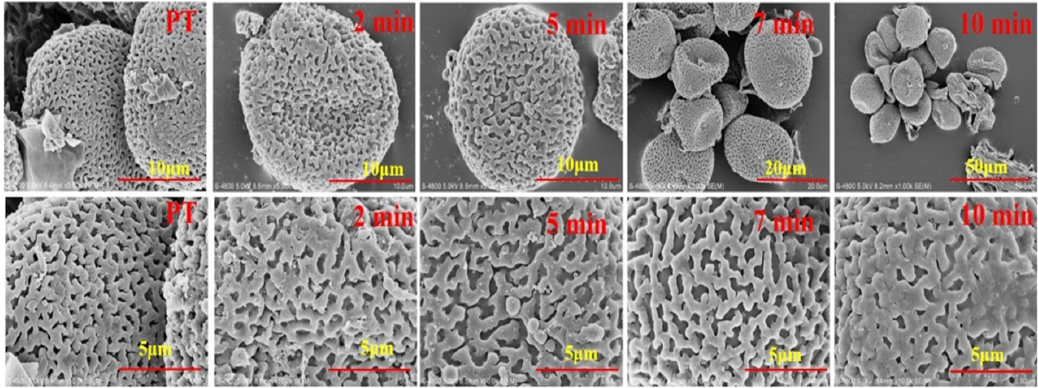
Figure 1. Scanning Electron Microscope of pollen T ypha (PT) samples during frying processes.